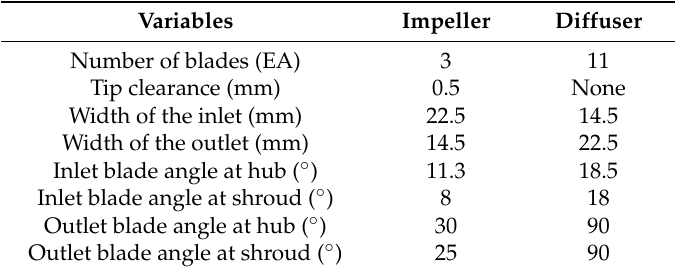
Table 1. Design information of second-stage base model.